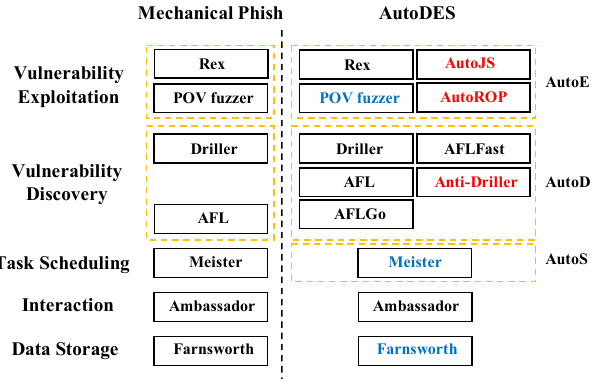
Figure 1. The difference between AutoDES and Mechanical Phish, where the red text represents the newly added modules and the blue text represents the improved ones. We omit the unused and unchanged parts of Mechanical Phish.